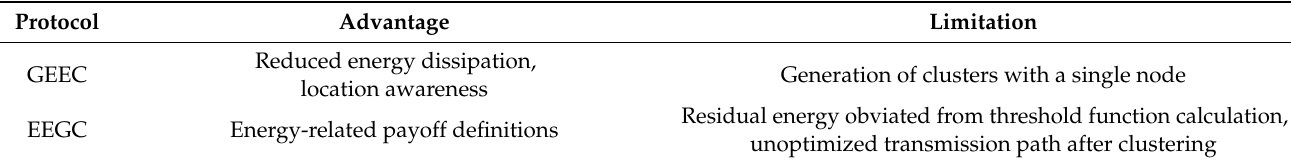
Table 1. Conventional routing protocols based on game theory in terms of technical strengths and